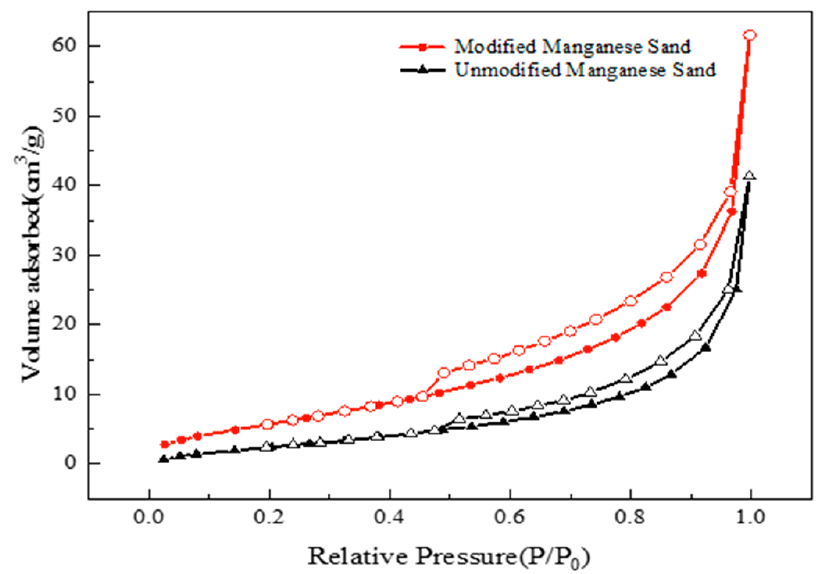
Figure 2. Nitrogen adsorption–desorption curve.